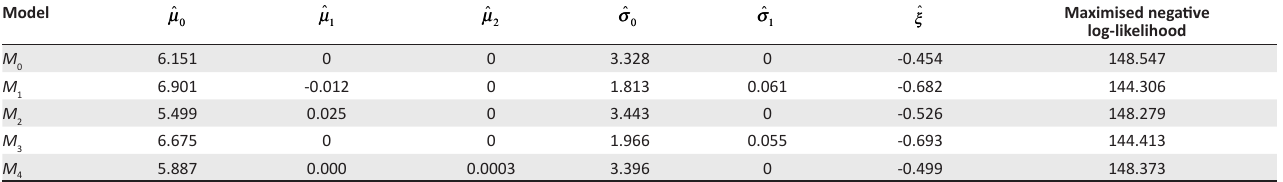
TABLE 3: Annual daily maximum time-dependent generalised extreme value models for Sicacate for the period 1952–2010.